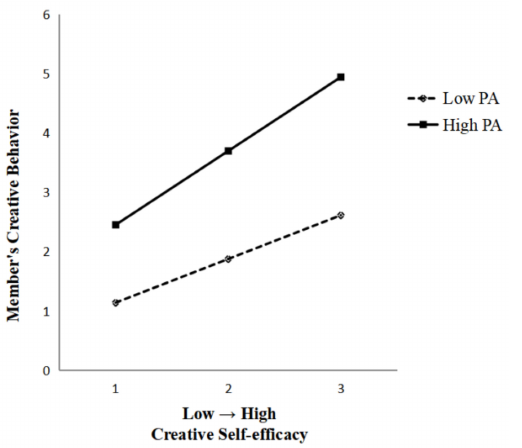
Figure 3. Interaction between creative self-efficacy and members’ creative